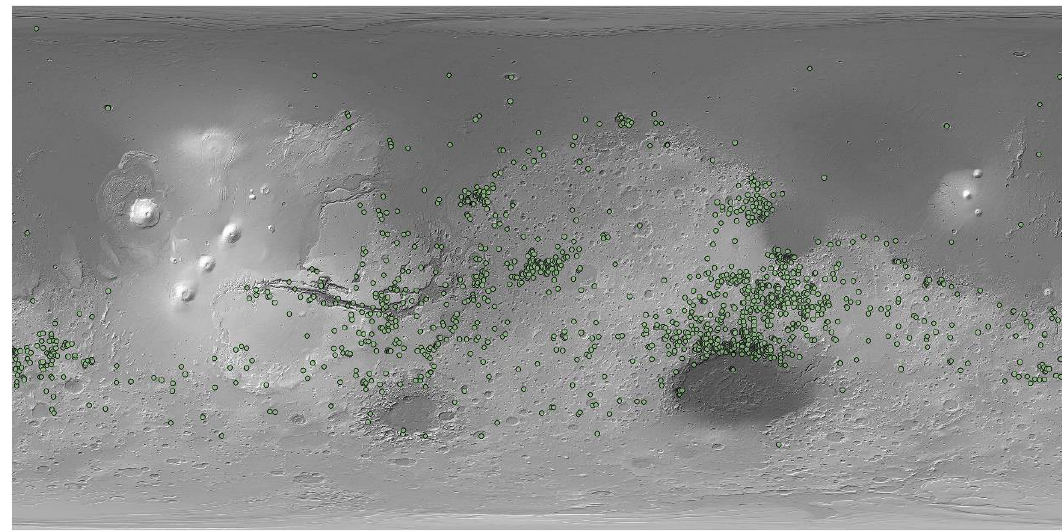
Figure 1. Mars ’ hydrated minerals map. Figure 1. Mars’ hydrated minerals